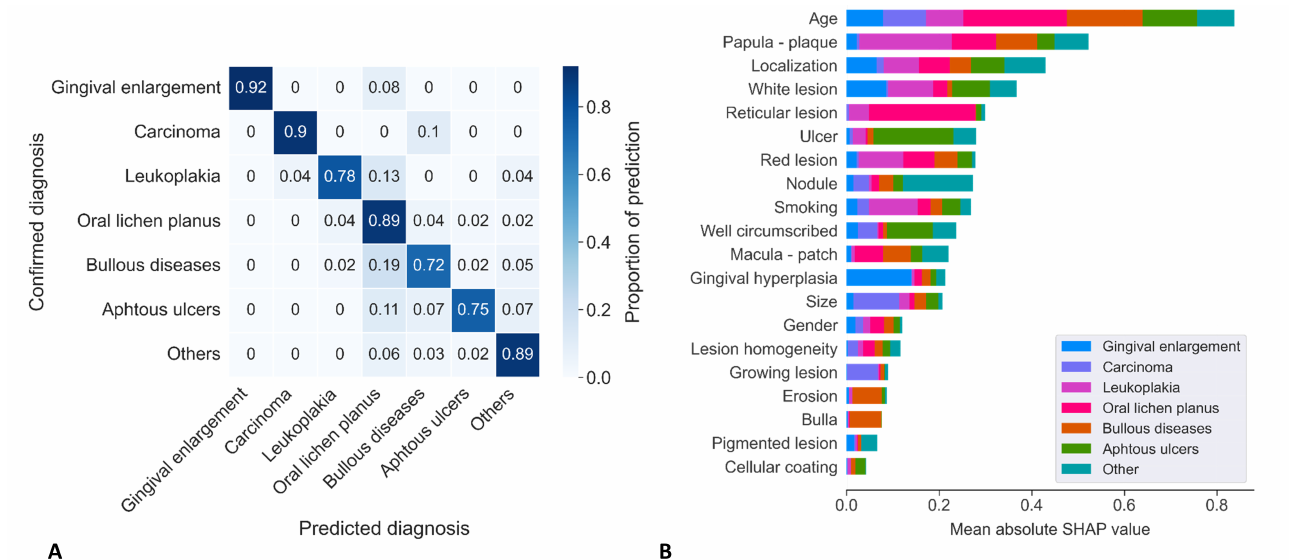
Figure 1. Confusion matrix for LightGBM model and Feature importance for overall predictions. ( A ) The confusion matrix describes the performance of the LightGBM classifier on the test dataset. The number of correctly classified lesions ranged from 92% to 72% depending on the different diag- noses evaluated. ( B ) SHAP feature importance for the LightGBM trained model for predicting oral mucosa lesions measured as the mean absolute SHAP values. Abbreviations: ATC A, Anatomical